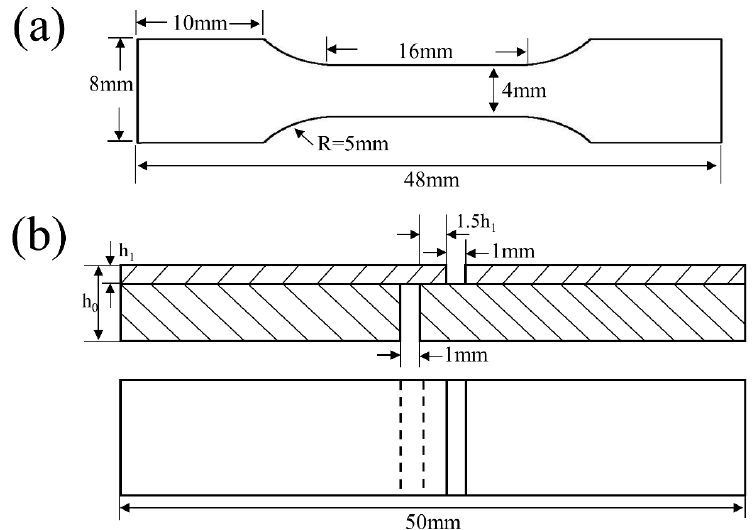
Figure 2. Schematic figure of ( a ) tensile test and ( b ) tensile shear test.